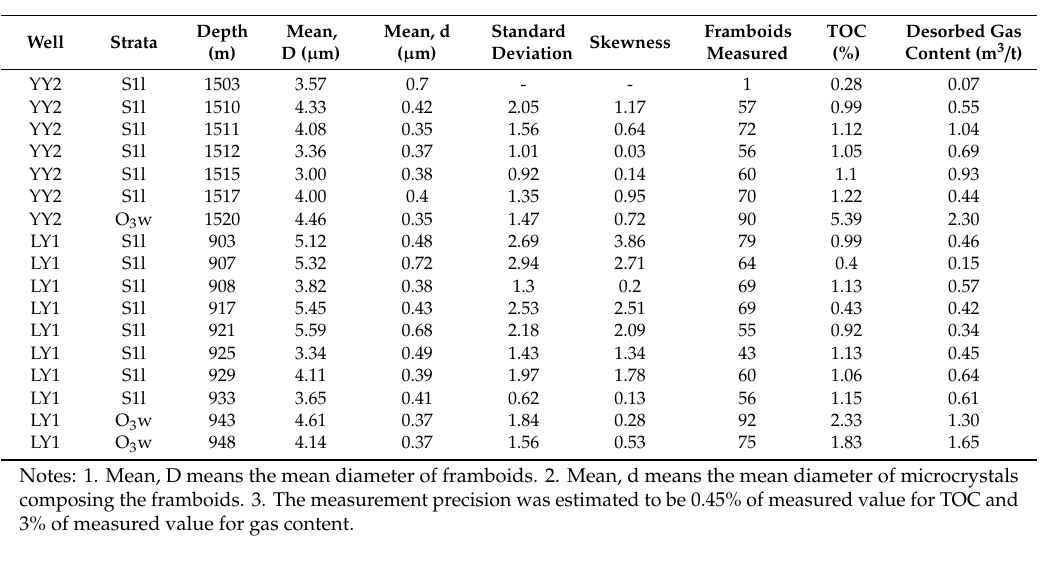
Table 2. Morphological characteristics of pyrite in the Wufeng and Longmaxi shales.